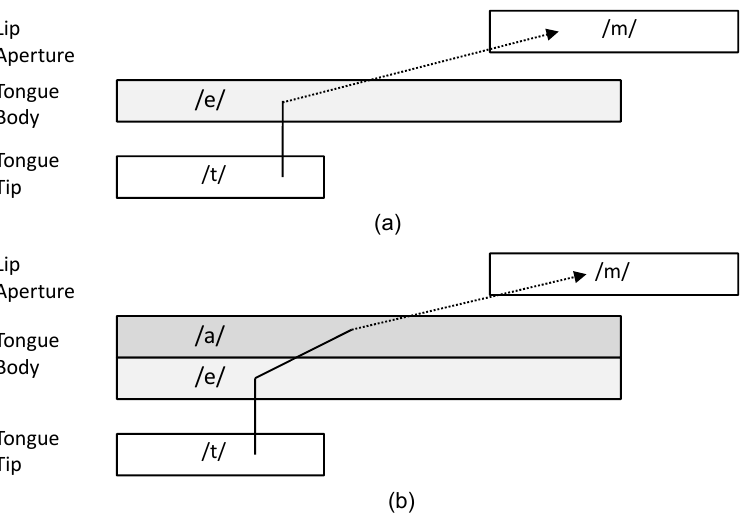
Figure 1. Coupling graph and activation intervals (gestural representations) for modeled stimuli. In-phase coupling is represented by continuous lines, while anti-phase coupling by dashed arrows. The gestures in curly brackets are not shown. (a) Modeled underived /e/ in ['te.m{ ə }]’homework: /t/ and /e/ are coupled in-phase, /e/ and /m/ are coupled anti-phase; (b) Modeled blended /e/ in [te.m{ ə .'tor}]’the evening show’: /e/ and /a/ are coupled in- -phase to each other and respectively in-phase to /t/ and anti-phase to